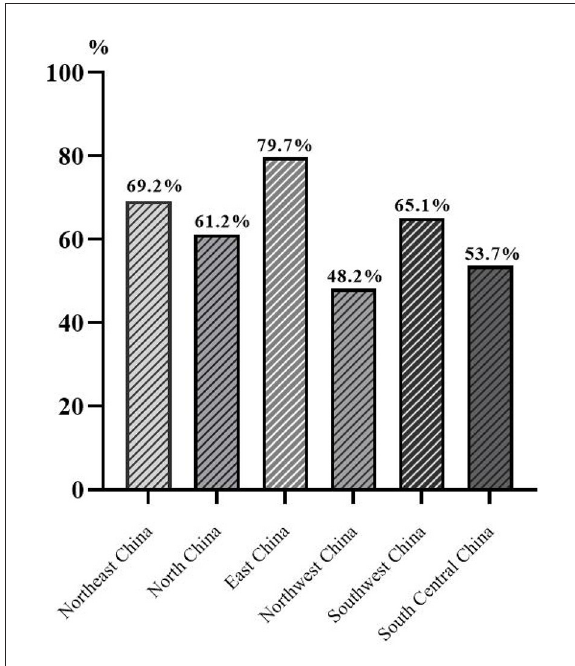
FIGURE5 The detection rate of poor vision in children and adolescents by region.